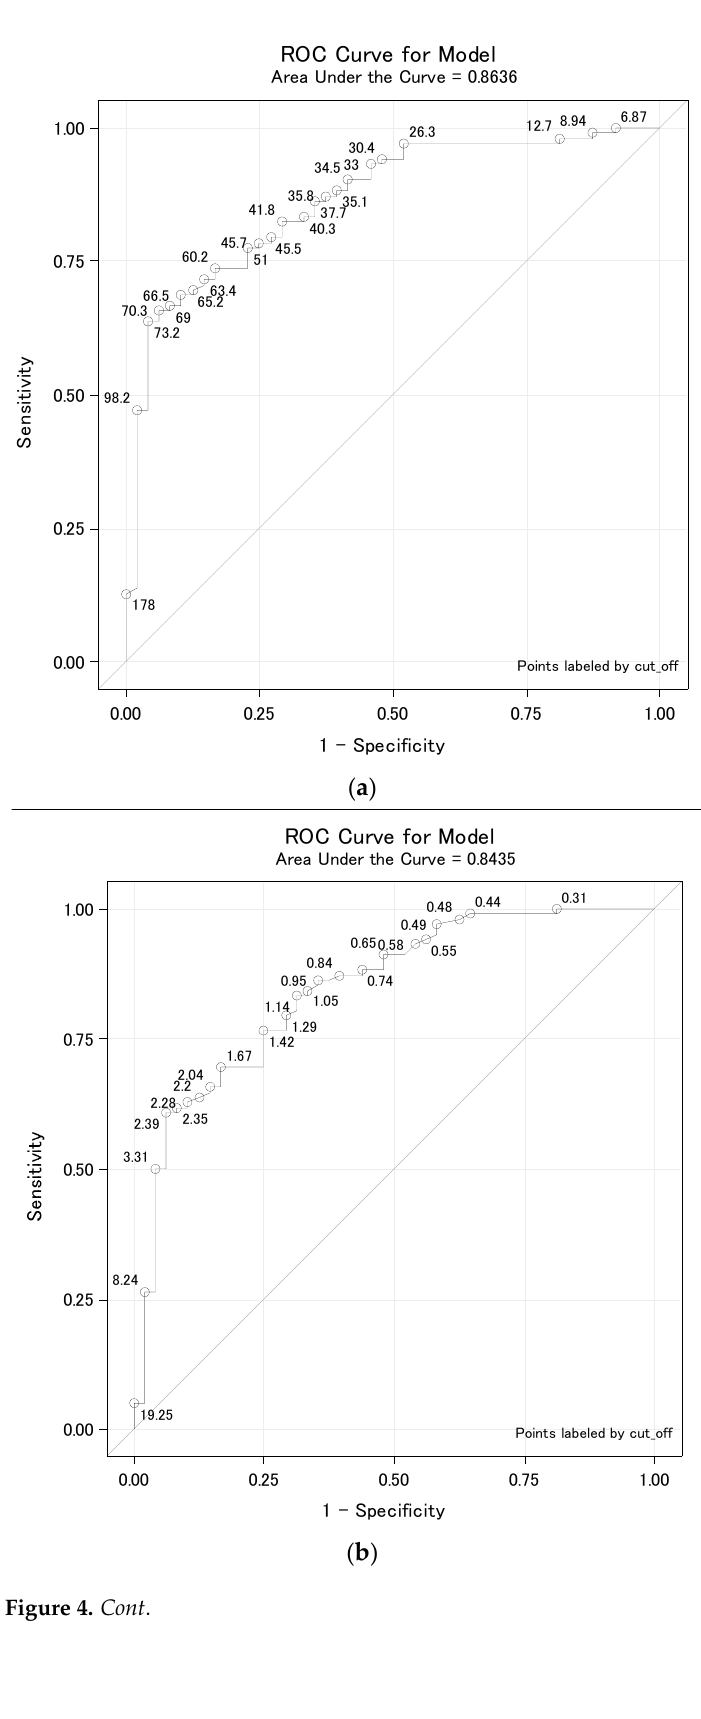
ROC Curve for Model Area Under the Curve = 0.8636